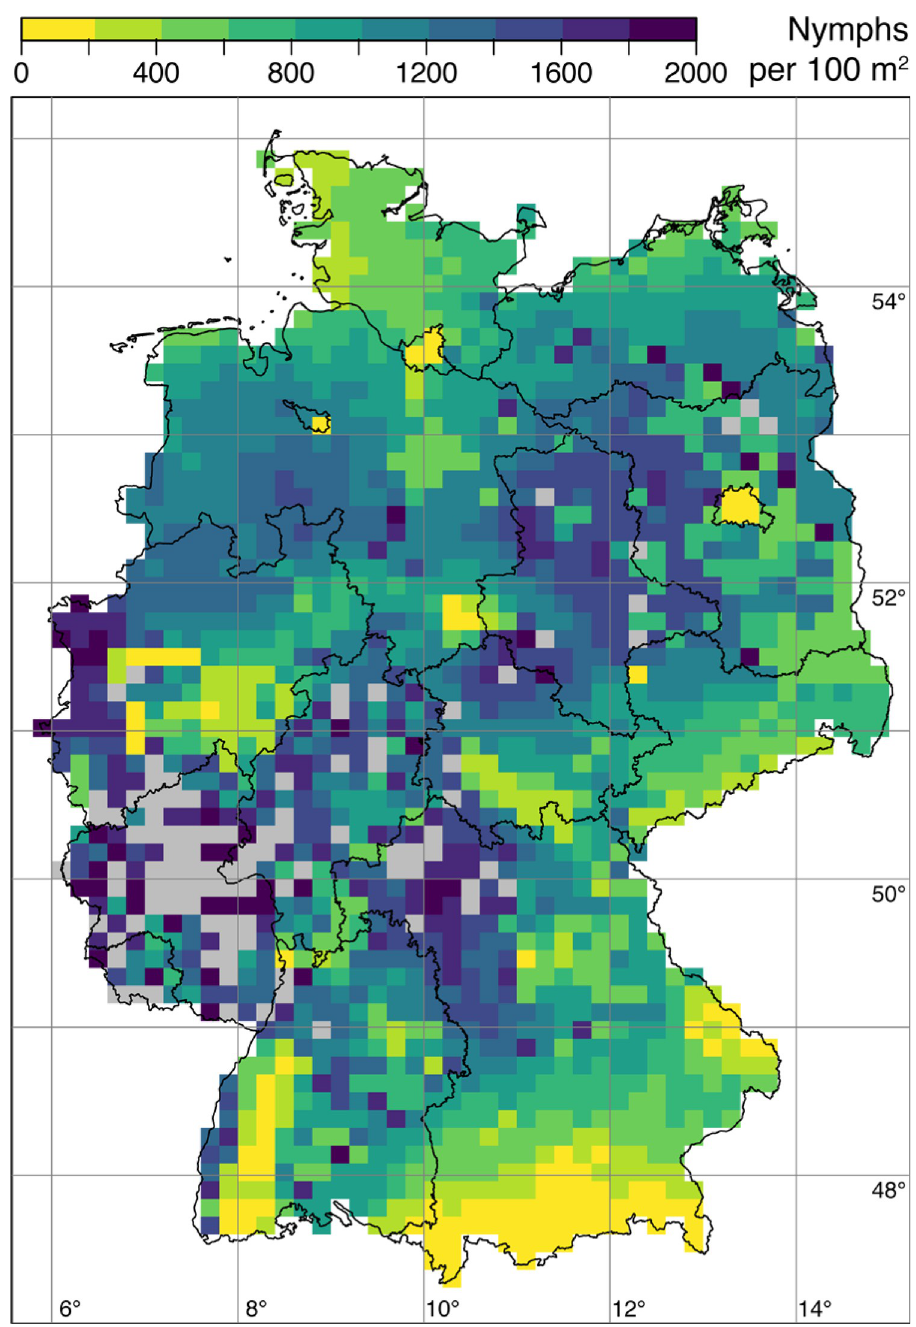
Fig 9. Germany map of nymphal I . ricinus density differences depicting the change between the reference period (1971–2000) and the long-term scenario (2070–2099). If the density difference exceeds the threshold of 2,000 nymphs / 100 m 2 , the grid cells are indicated in grey. State and federal state boundaries were taken from the GADM, the database of global administrative areas